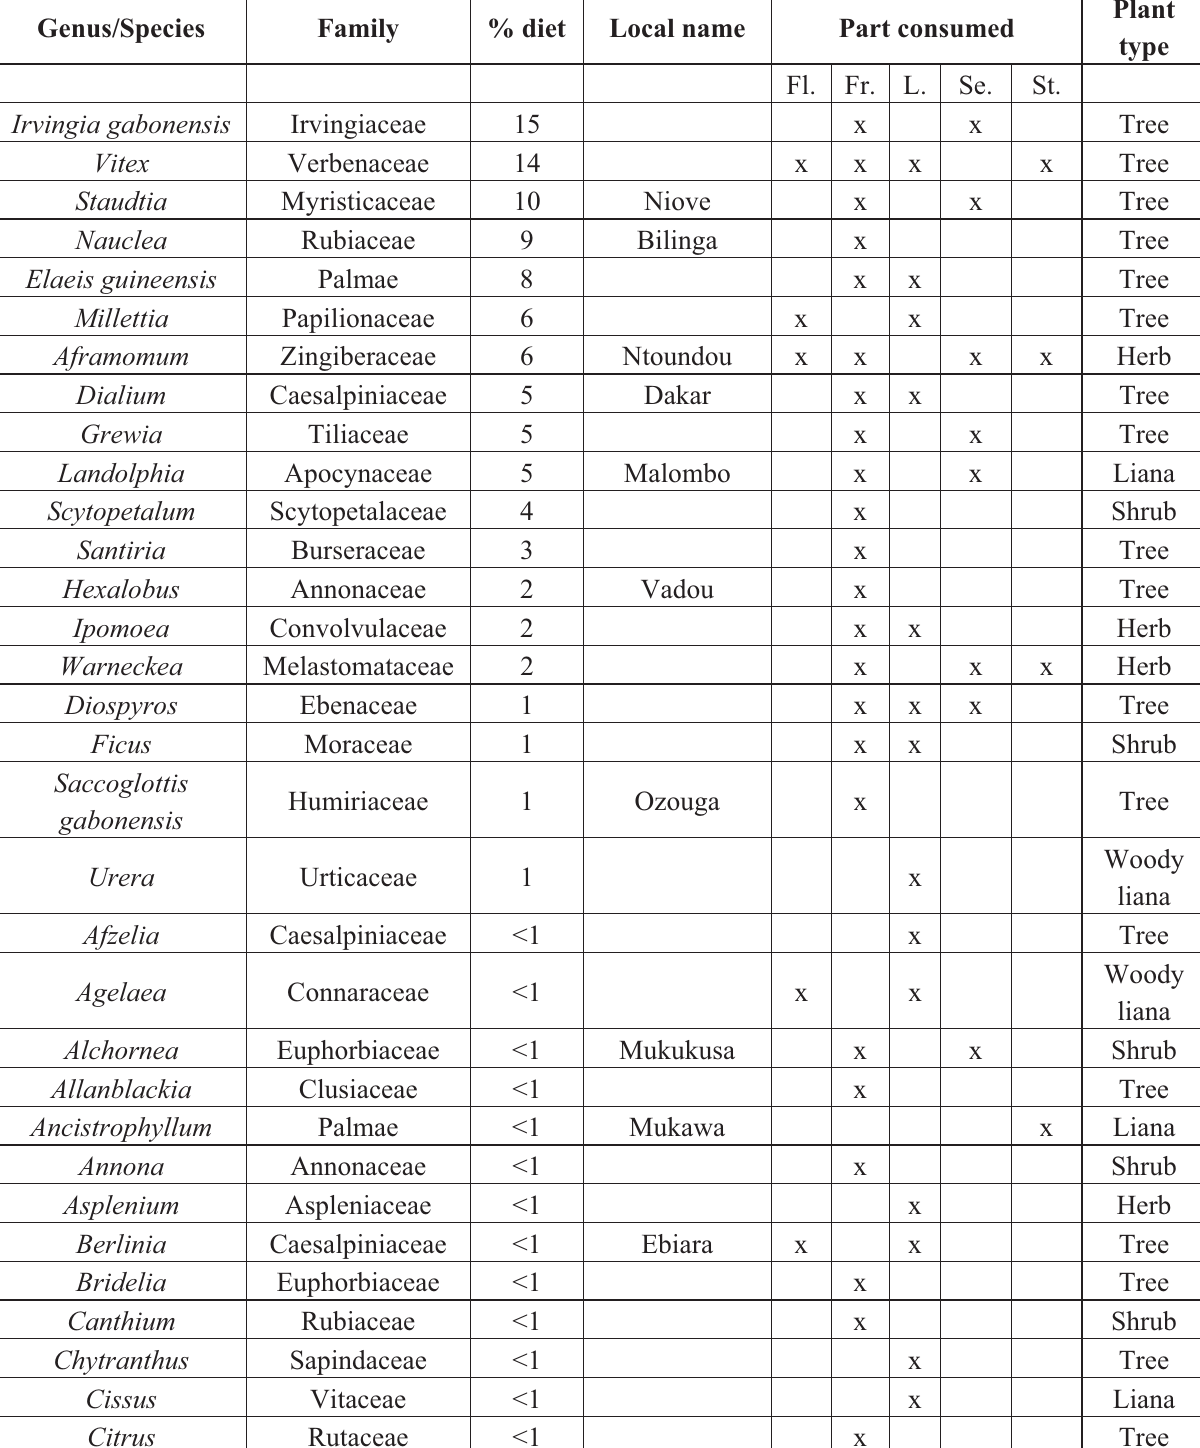
Table 3. Plant items eaten, listed in order of importance in diet: Fruit (Fr.), Leaf (L.), Flower (Fl.), Seed (Se.), Stem (St.). Herb: herbaceous plant up to 5 m height [25–27]. Shrub: 1–2 m height; 2 m height & 10 cm in diameter; 10–20 cm in diameter [25]. Tree: 20–50 cm in diameter, 50–100 cm in diameter, more than 100 cm in diameter [25]. Liana: supple stems with contortion, tendrils, hooks of great heights. Woody liana & herbaceous liana differ with the woodiness of the stem